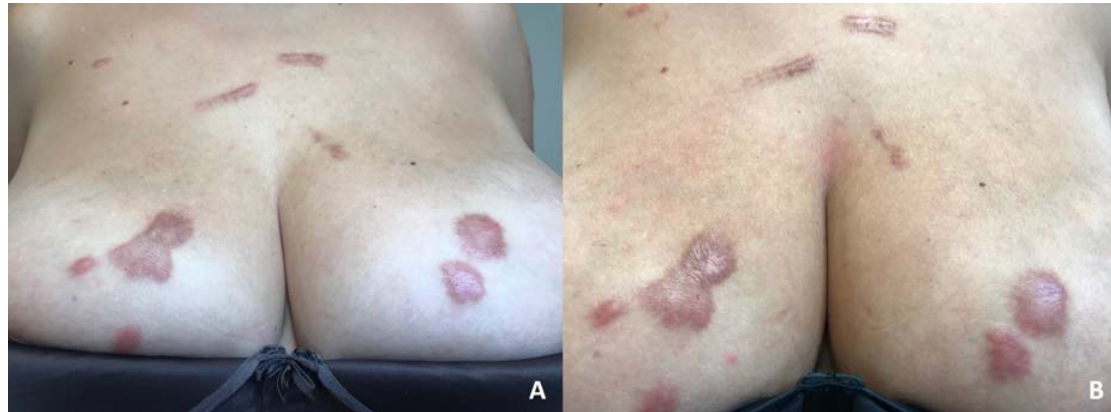
Figure 1. Spontaneous keloids on the chest and breasts of the patient before ( 1A ) and after ( 1B ) the treatment with UVA-1 phototherapy.